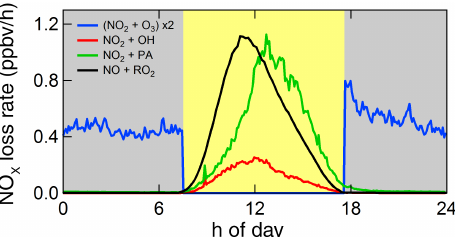
Figure 5. Daytime and nighttime loss rates of NO x in 2013 through the major oxidation pathways. Concentrations of OH and PA and the production rate of organic nitrates (NO + RO 2 ) were supplied by the Master Chemical Mechanism box model used by Edwards et al. (2013). The daytime NO 3 production is set to zero because of the fast NO 3 photolysis and reaction with photochemically gener- ated NO, and doubled at night due to Reaction (R5). The integrated nighttime loss toward HNO 3 is 5.9 times greater than during the